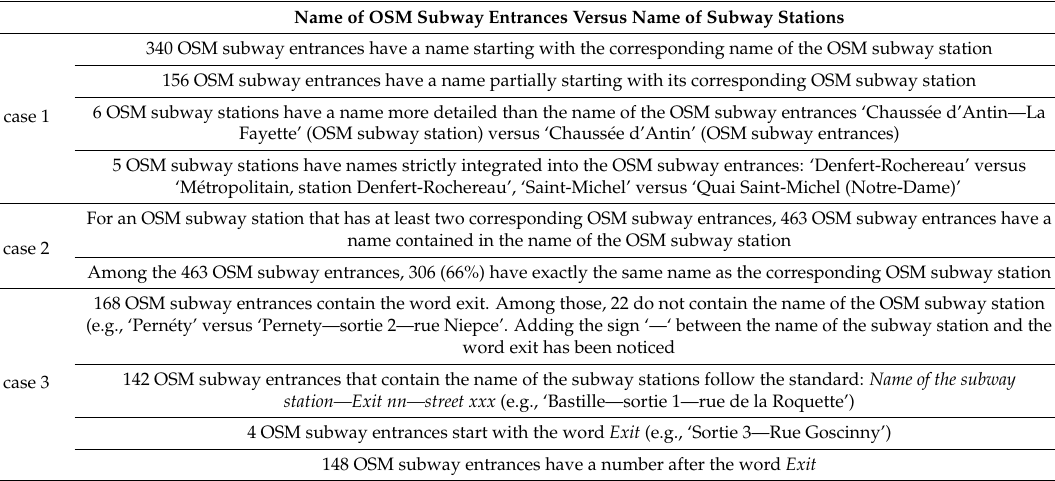
Table 9. Data quality analysis with respect to the observed naming standard for OSM subway